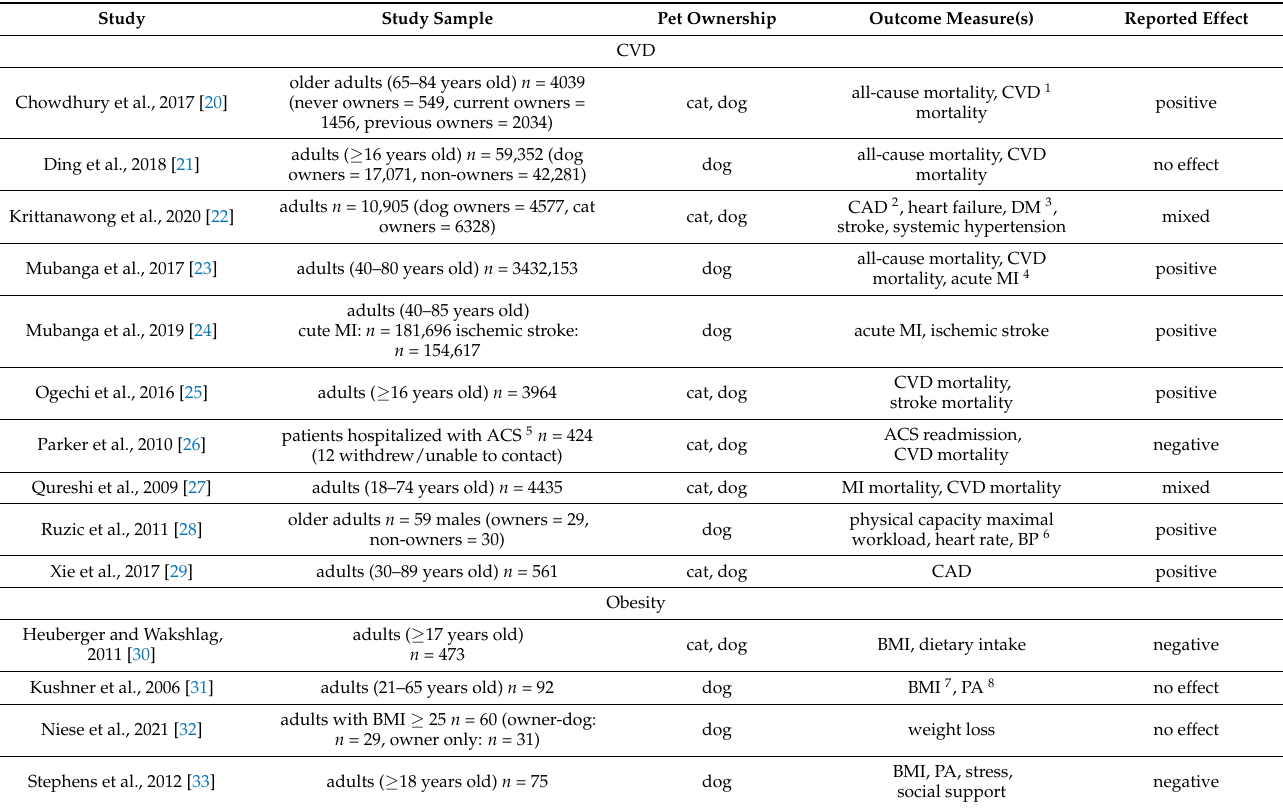
1 CVD: cardiovascular disease; 2 CAD: coronary artery disease; 3 DM: diabetes mellitus; 4 MI: myocardial infarction; 5 ACS: acute coronary syndrome; 6 BP: blood pressure; 7 BMI: body mass index; 8 PA: physical